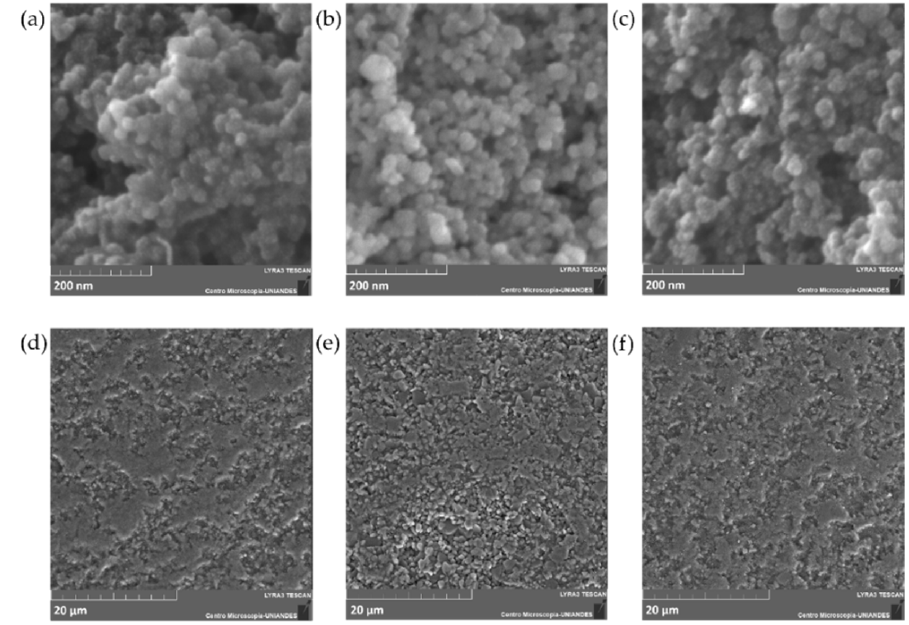
Figure 2. SEM images of ( a ) Fe 3 O 4 NPs, ( b ) Fe 3 O 4 NPs @APTES, ( c ) Fe 3 O 4 NPs after Cd removal, ( d ) Al 2 O 3 spheres, ( e ) Al 2 O 3 @APTES, and ( f ) Al 2 O 3 spheres after Cd removal.